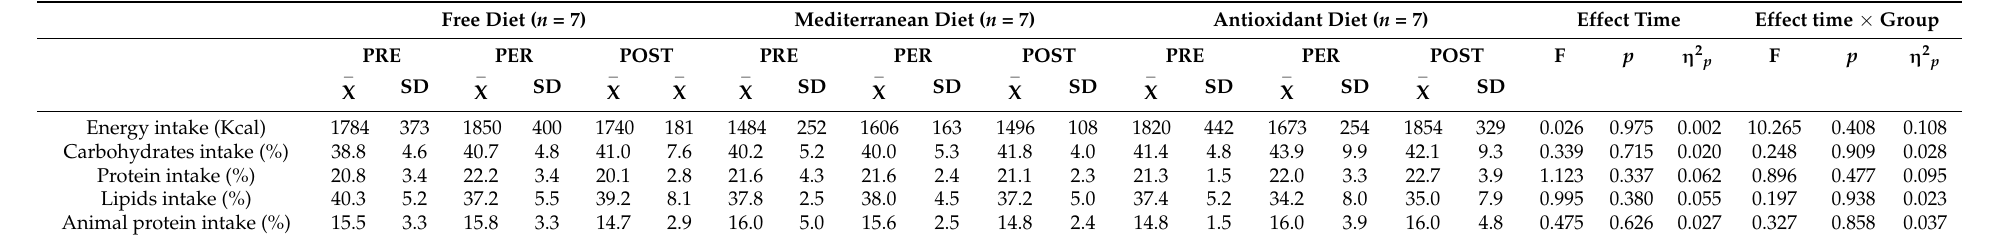
Table 4. Dietary intake variables at pre-, during, and post-intervention times in the free diet, Mediterranean diet, and antioxidant-rich diet